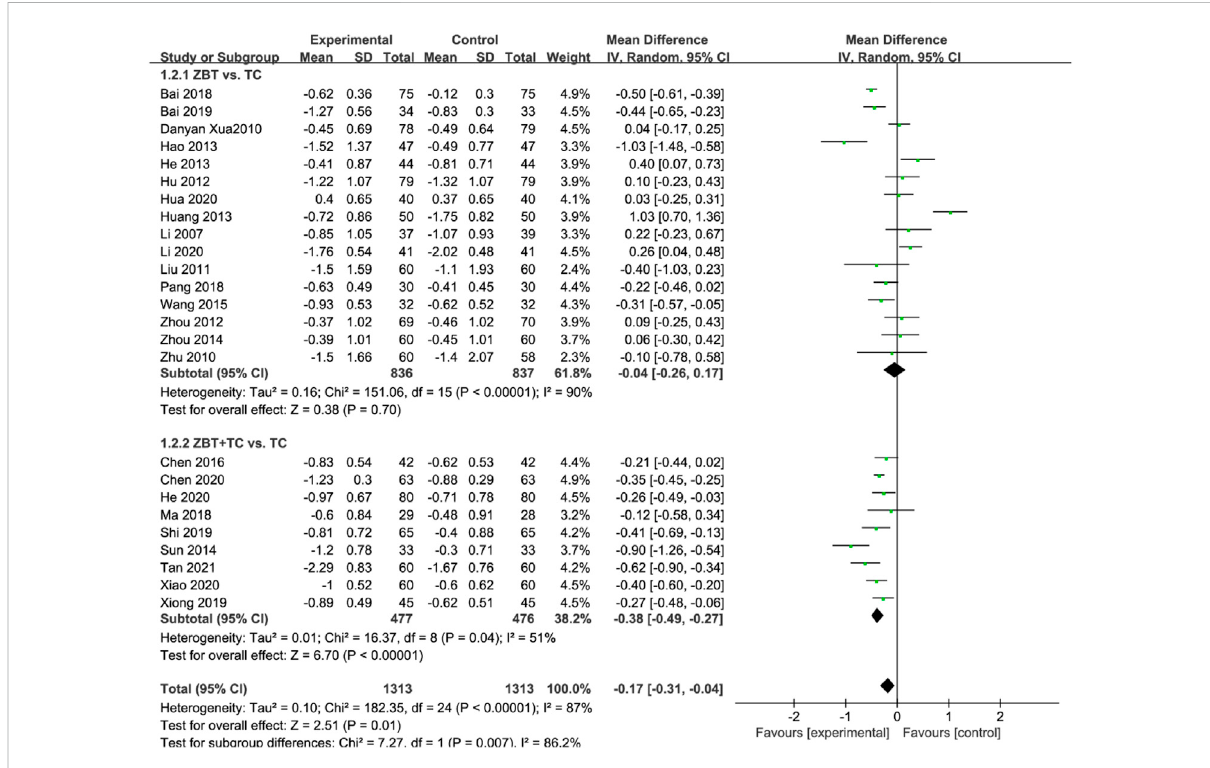
FIGURE 4 Meta-analysis results of the effect of Zhibitai (ZBT) vs. conventional therapy (CT) on triglyceride (TG).